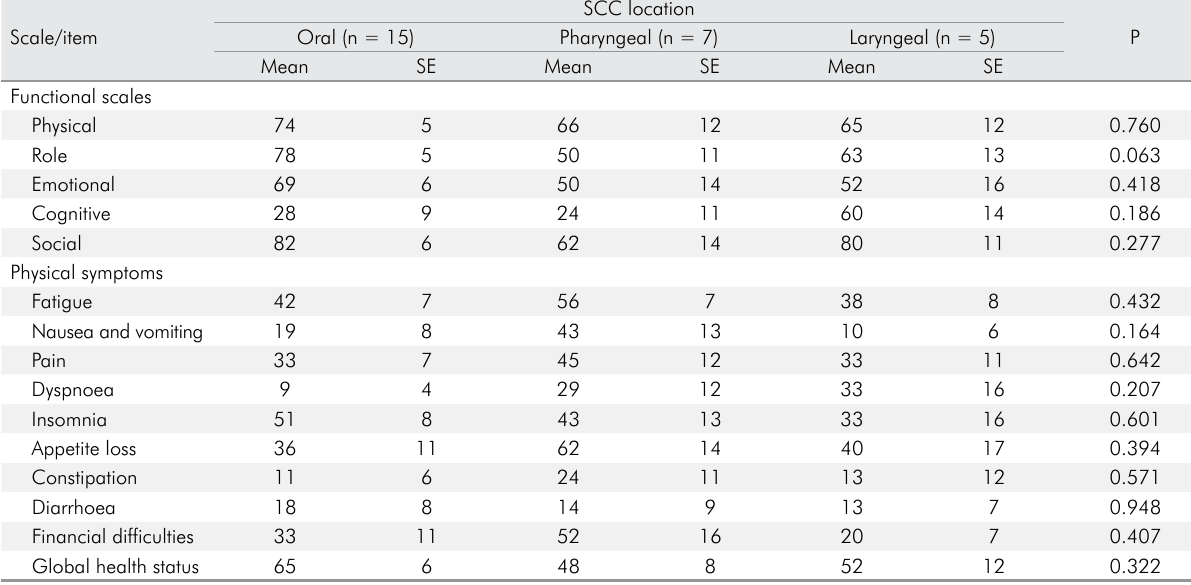
Table 1. QLQ-C30 scores according to tumor